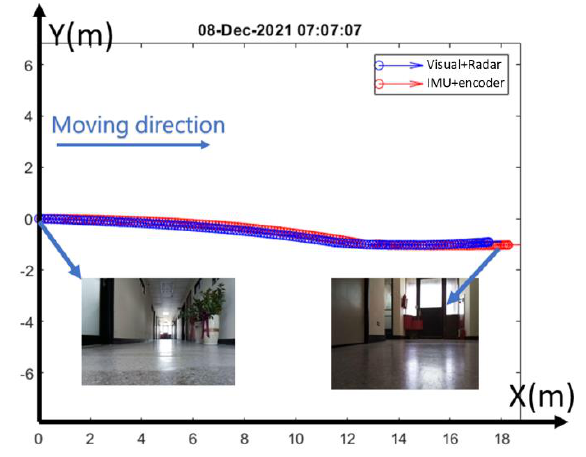
Figure 11. The comparison of trajectory between Visual Radar Odometry and IMU in scenario 1 (Hallway)